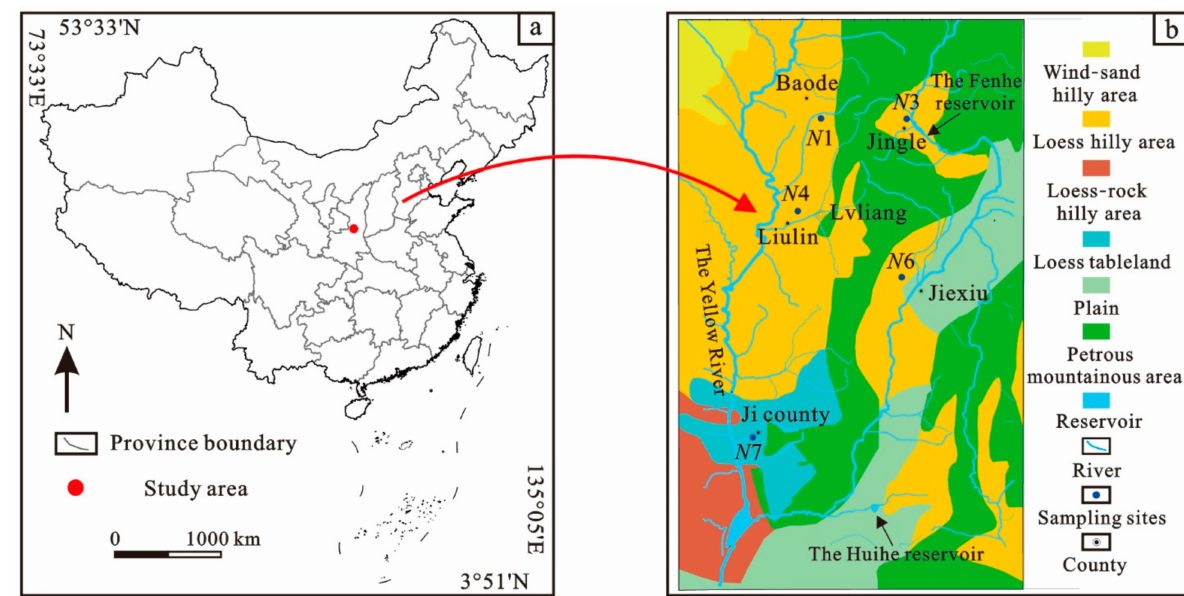
Figure 1. Location of the study area: ( a ) site map of Lvliang Mountainous in China, and ( b ) surface relief map of the study area showing locations of the sampling